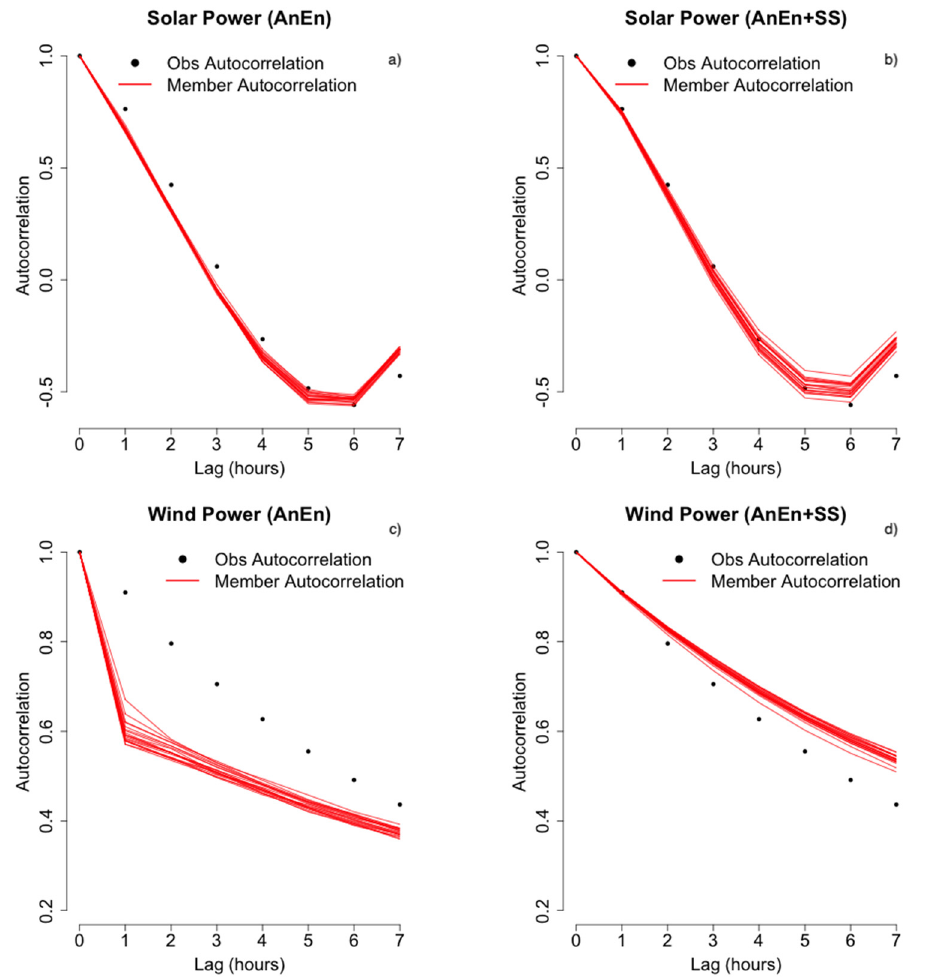
Figure 5. Observed (black) and predicted (ensemble members, red) autocorrelation of power with ( b , d ) and without Schaake shuffle (SS), ( a , c ) as a function of time lag for 1 PV farm ( a , b ) and 1 wind turbine ( c , d ).